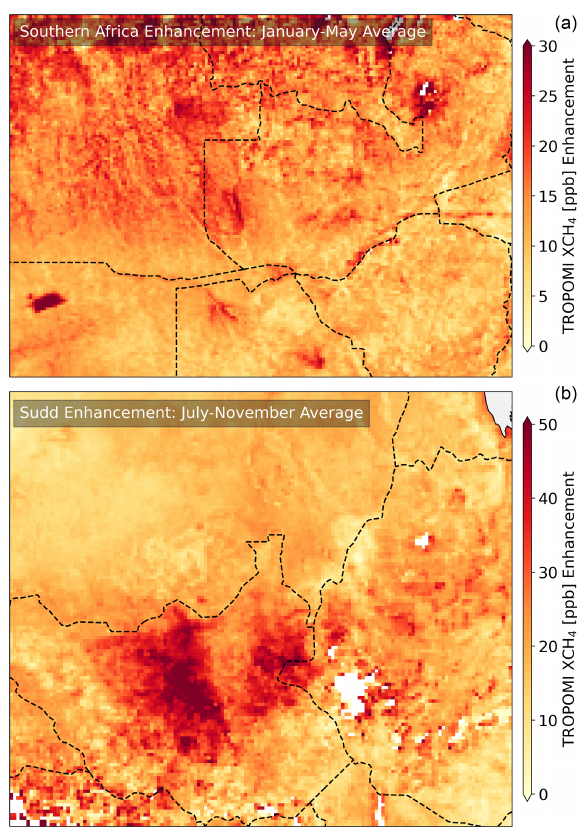
Figure 11. Enhancement in TROPOMI XCH 4 calculated by grid- ding the data into daily 0 . 1 ◦ × 0 . 1 ◦ bins and subtracting a baseline for each latitude bin. The baseline is calculated as the 5th percentile of each latitude bin with a rolling five-bin (i.e. 0.5 ◦ latitude) aver- age used to smooth out fluctuations. The enhancements are shown for the Southern Africa and Sudd regions, averaged over the months where the wetland signal peaks, as indicated in Fig. 8. For South- ern Africa, it should be noted that the enhancement over the Etosha Pan in Namibia (south-west corner of the domain) is likely overes- timated due to particular spectral albedo variations within the fitting window used in the satellite retrievals. Finally, there were not suffi- cient cloud-free observations for the Congo